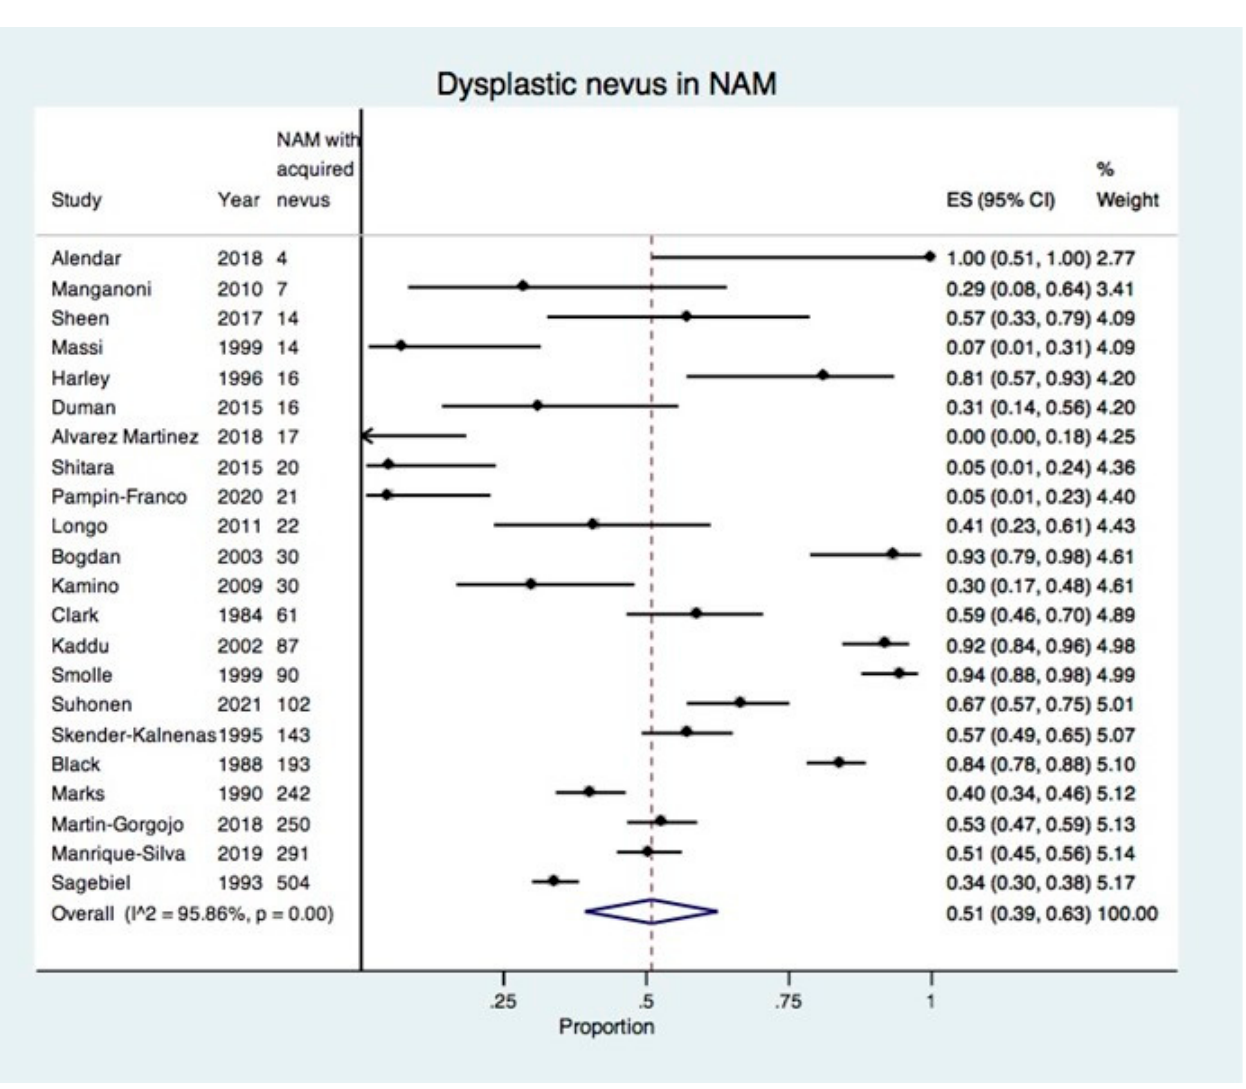
Figure 2. Forest plot showing the proportion of dysplastic nevus in all included studies reporting NAM developing in an acquired nevus (22 studies, 2174 NAMs with an acquired nevus) [7,20–40]. 3.4. Sensitivity Meta-Analysis of Studies Including 30 or More NAMs with an Acquired Nevus (n = 12) There were 12 studies reporting 30 or more NAMs with an acquired nevus, including a total of 2023 cases [7,22,23,26,27,30–32,35,38–40] (Table 1). The meta-analysis of these studies showed the presence of dysplastic nevus in 65% of acquired nevus-NAM (95% CI: 51–77%) (Figure 3). There was high heterogeneity with I 2 : 97.16% ( p < 0.01), which was due to the variability of the proportion of dysplastic nevus in the included studies, ranging from 30% to 94.4% (Table 1). in the presence or absence of nevus in melanoma was additionally excluded from the meta-analysis, the results remained similar, with dysplastic nevus present in 65% of NAM (95% CI: